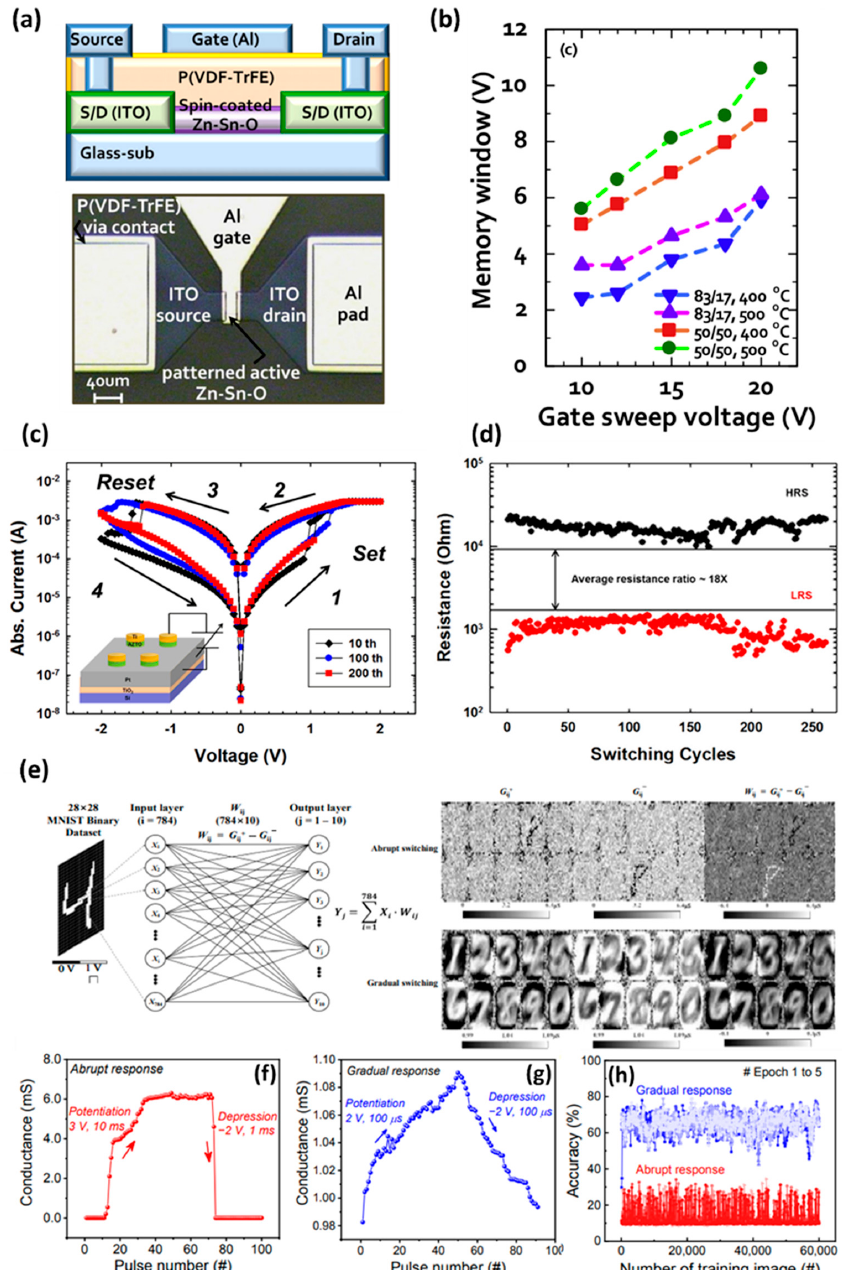
Figure 4. ( a ) Schematic diagram and optical image of a top-gate MTFT fabricated from the solution- processed ZTO channel and the P(VDF-TrFE) gate insulator. ( b ) Variation of memory window according to the annealing and composition ratio of zinc and tin in the ZTO film. The sweep range of V G was performed from ± 10 to ± 20 V (adapted from [74] with permission from Elsevier). ( c ) The bipolar resistance switching I-V curves in the fabricated Ti/ZTO/Pt structure device. ( d ) Switching cycling test with a current compliance of 3 mA (adapted from [75] with permission from AIP Pub- lishing). ( e ) Device designed in the system simulation framework for MNIST pattern categorization: single-layer neural network for MNIST pattern categorization. A synaptic weight map showing the results after learning 60,000 training images using abrupt and gradual switching experimental models. Potentiation and depression results according to the ( f ) abrupt response and ( g ) gradual response of the fabricated memristor devices. ( h ) Accuracy of pattern recognition according to gradual response and abrupt response (adapted from [76] with permission from